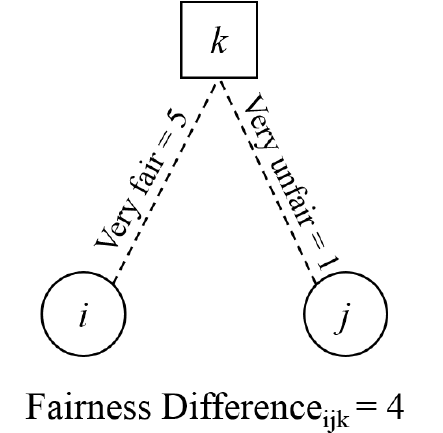
Fig. 1 . Illustration of differences in perceived procedural fairness between actors participating in a policy forum. Actors are depicted as circles and forums as